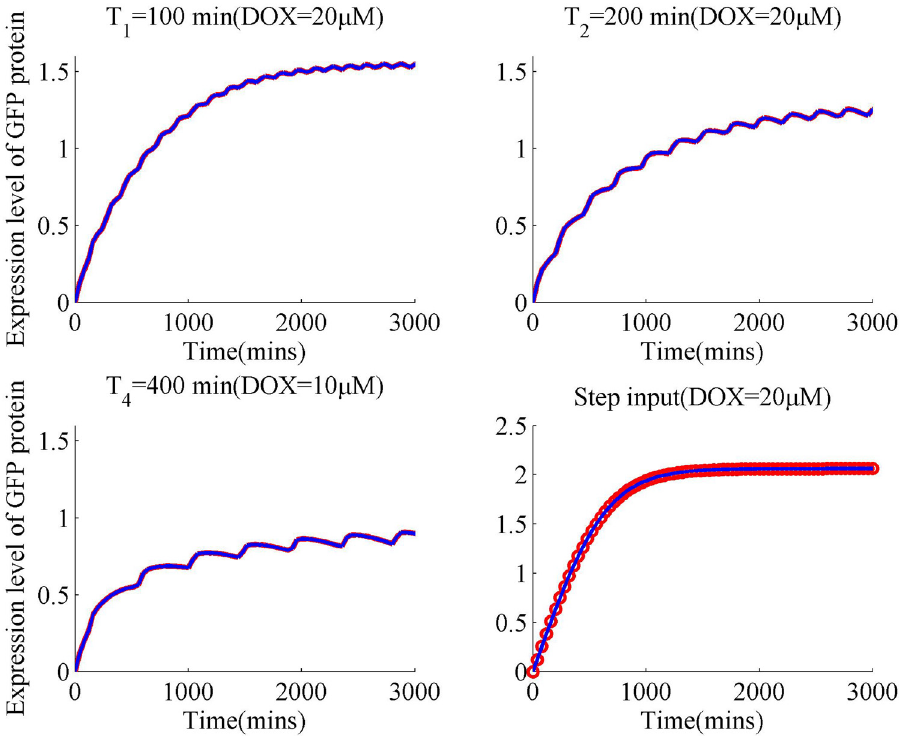
Fig 2. Curve fitting of unbuffered gene circuit using four types of input signals. The periods of first three square inputs are 100,200 and 400 mins respectively. In order to get stable response curve, the simulation time is set as 3000